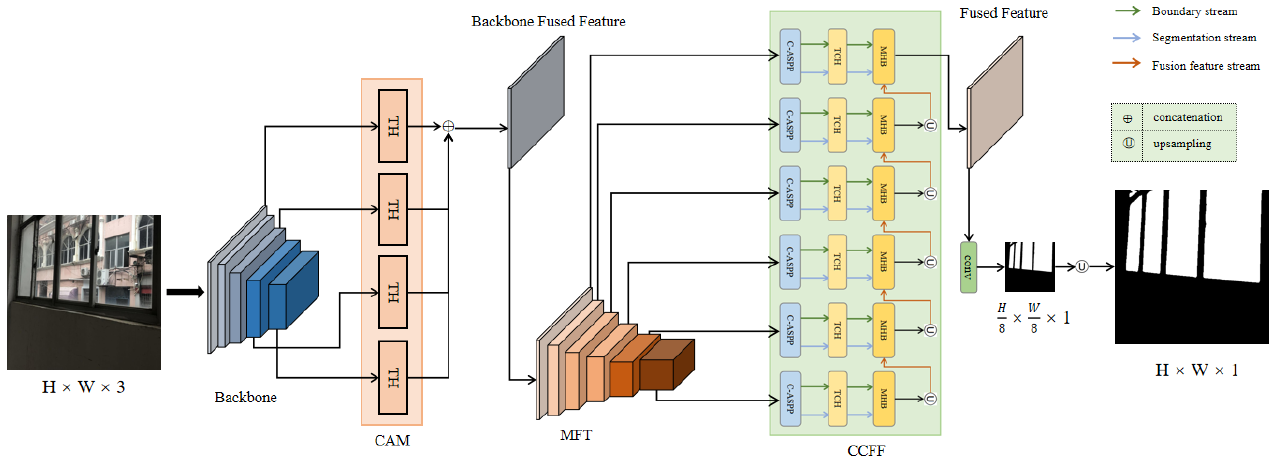
Figure 1. Overall framework structure of TGSNet .